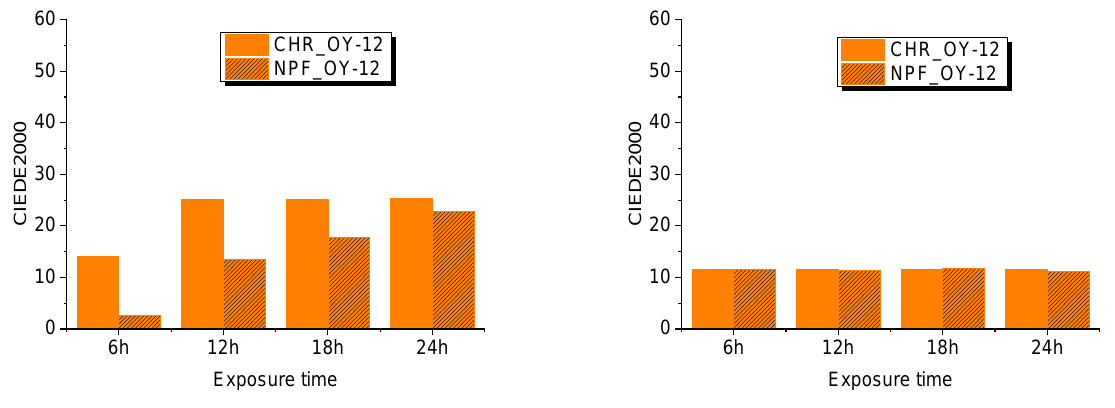
Figure 7. CIEDE2000 difference measured at 8 °C ( left ) and at 20 °C ( right ) on both test substrates printed with OY-12.